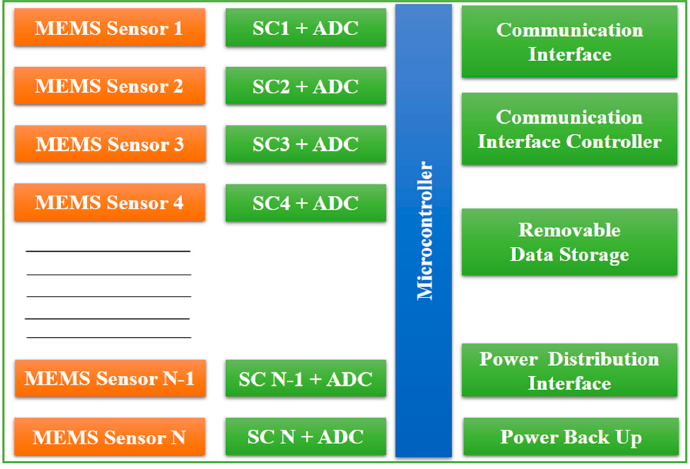
Figure 4. Conventional SHM Node Block Diagram.